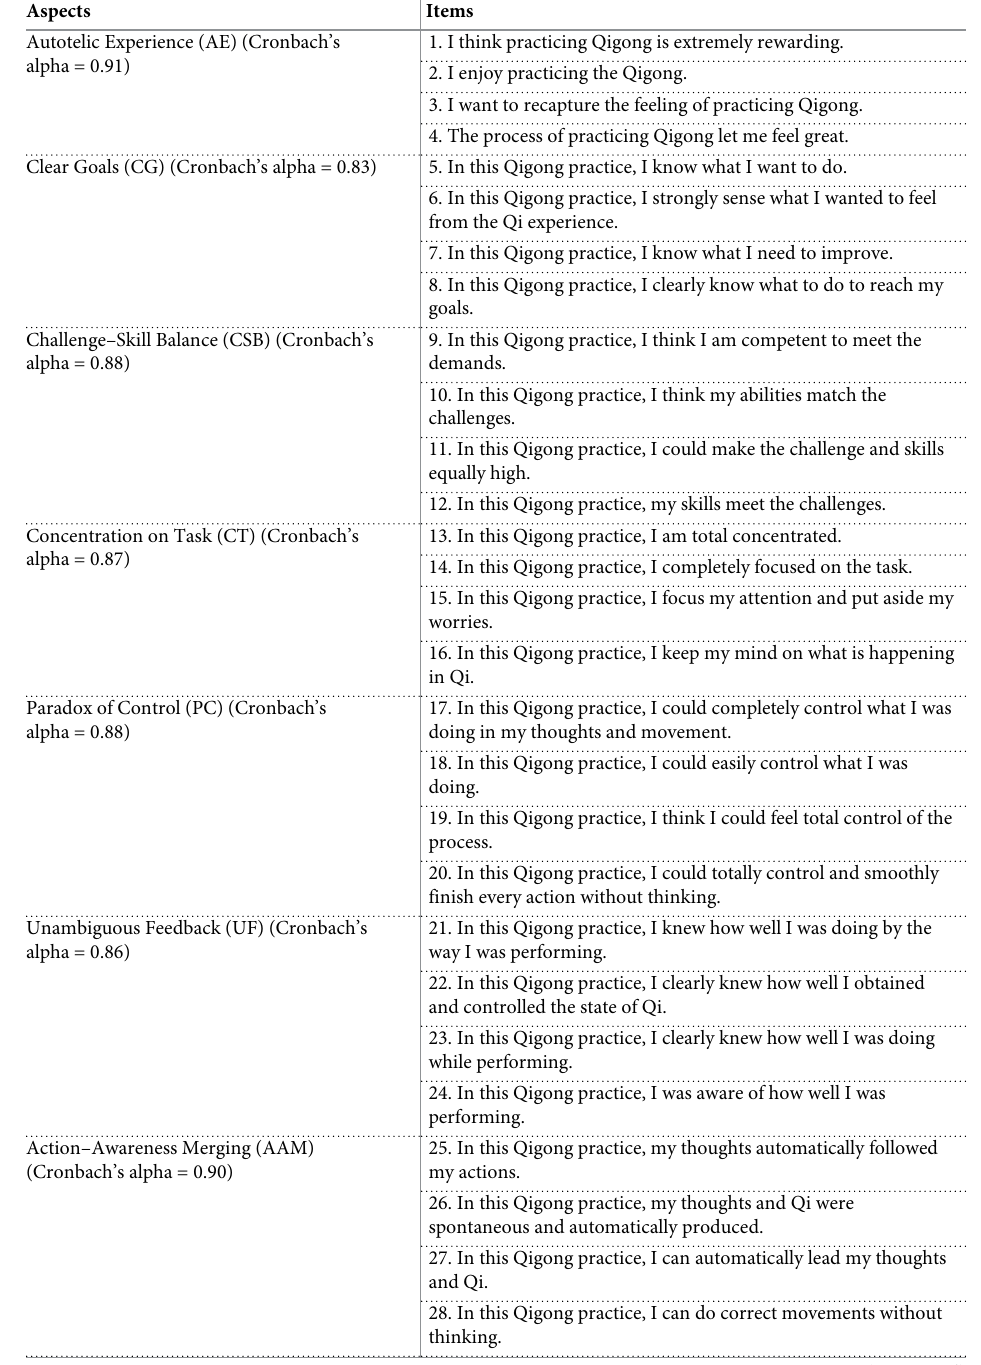
Table 4. The revised Flow State Scale